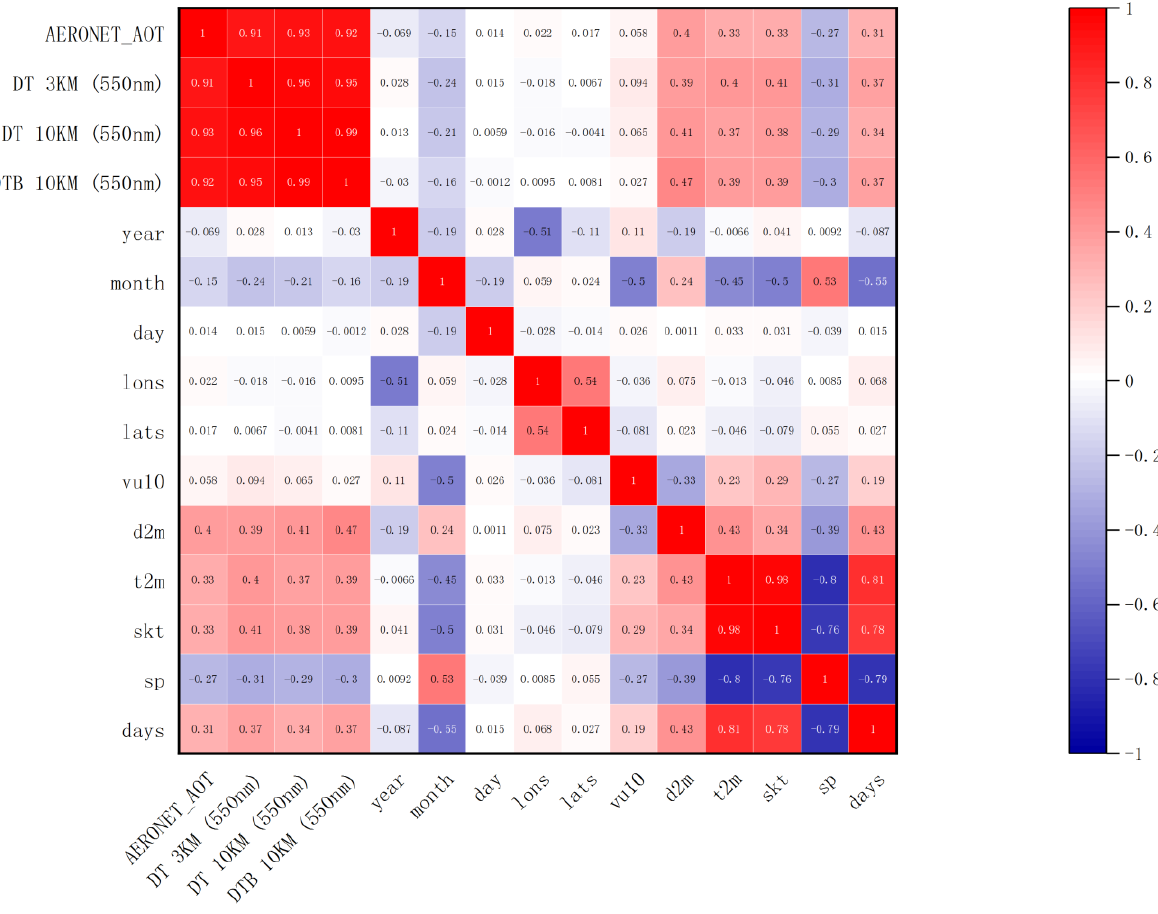
Figure 2. Correlation matrix of AOD